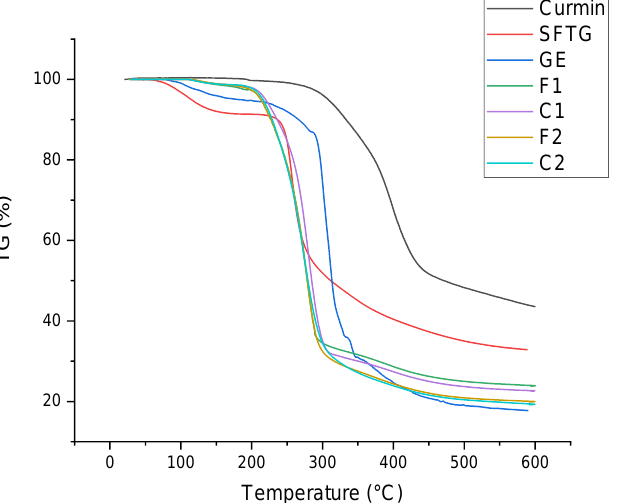
Figure 2. TGA of curcumin, SFTG, GE, and film samples. F1 (1GE: 1SFTG); F2 (2GE: 1SFTG); C1 (1GE: 1 SFTG/curcumin); C2 (2GE: 1SFTG/curcumin).